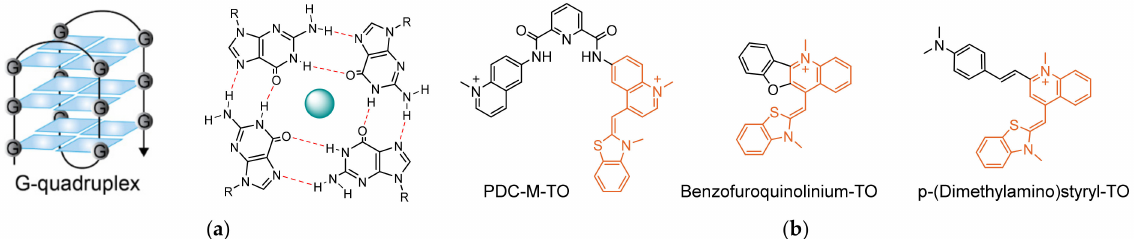
Figure 7. TO-based G-quadruplex-sensing probes. ( a ) Molecular structure and conformation of a representative G- quadruplex. G-tetrads are stacked parallel to one another with a stabilizing cation in the middle of each tetrad; ( b ) Examples of notable TO-based probes for selective sensing of